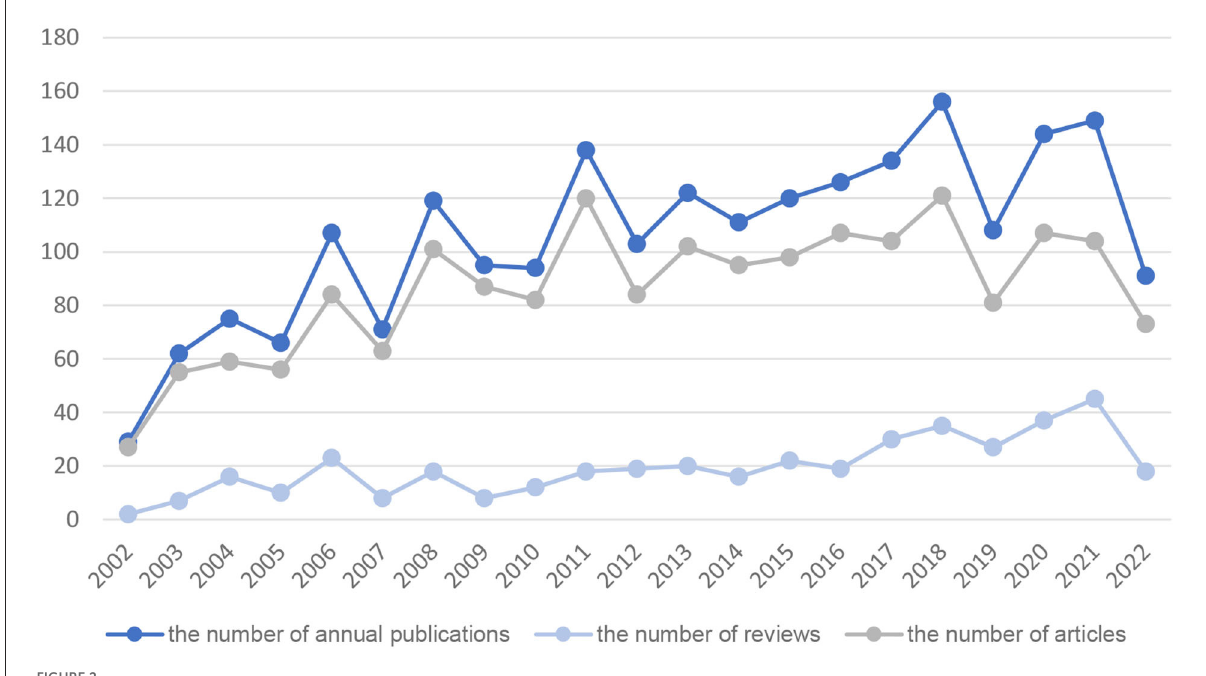
FIGURE2 Number of publications investigating FD by year over the past 20